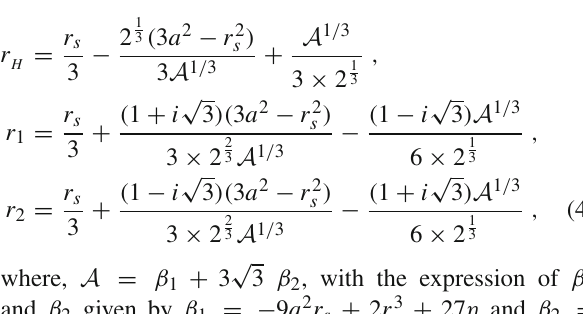
Fig. 1 In the above figure, we demonstrate the contours of the horizon structure in a radially deformed spacetime. Depending on the deforma- tion parameter η , the plots change accordingly and can have maximum three positive real solutions. Beside the inner and outer horizon, the presence of η introduces another real root which always exists. This would indicate that for no ranges of BH parameters the singularity can be naked. Here we set r s = 1